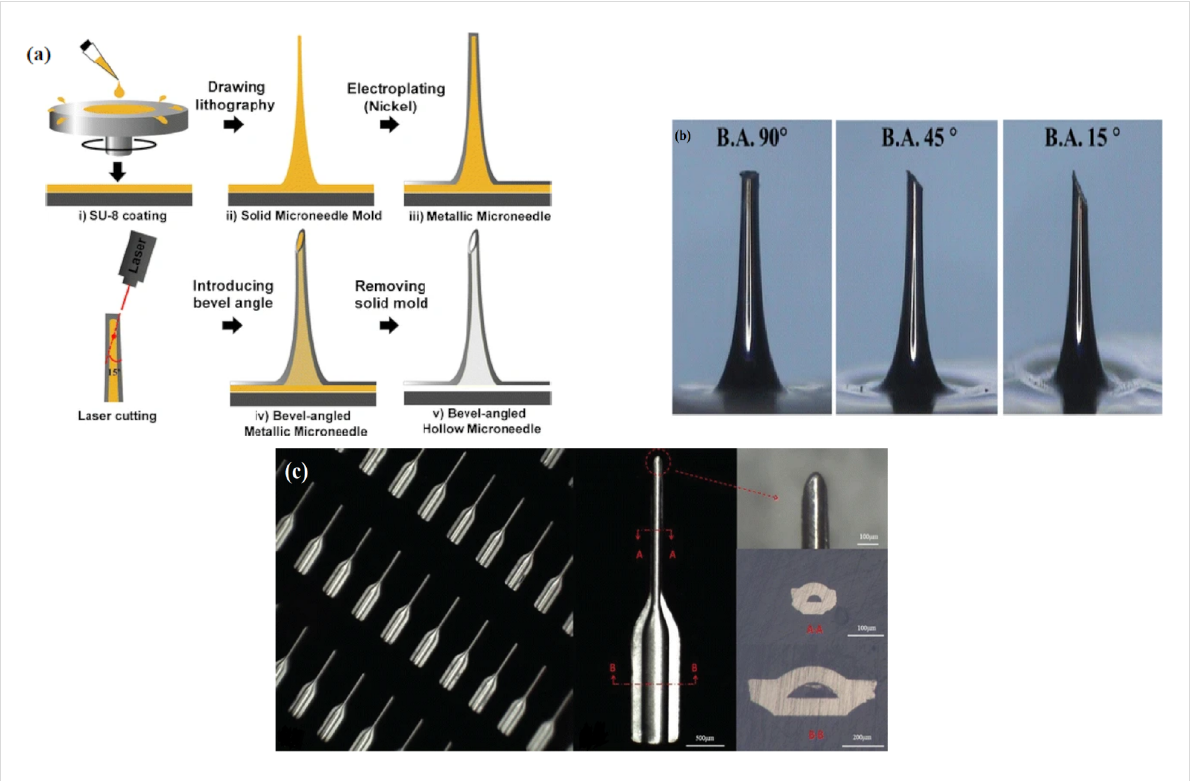
Figure 5: (a) A schematic illustration of the drawing lithography procedure for fabrication of nickel microneedles, (b) microneedles with 1800 μ m in height, bevel angles of 90°, 45°, and 15° and an inner diameter of 60 μ m for blood extraction [104]. (c) Hollow nickel microneedles with cross sectional views [105]. Figure 5a,b are from [104] and were reprinted by permission from Springer Nature from the journal Biomedical Microdevices (“An optimized hollow microneedle for minimally invasive blood extraction” by Li, C. G.; Lee, C. Y.; Lee, K.; Jung, H.), Copyright 2012 Springer